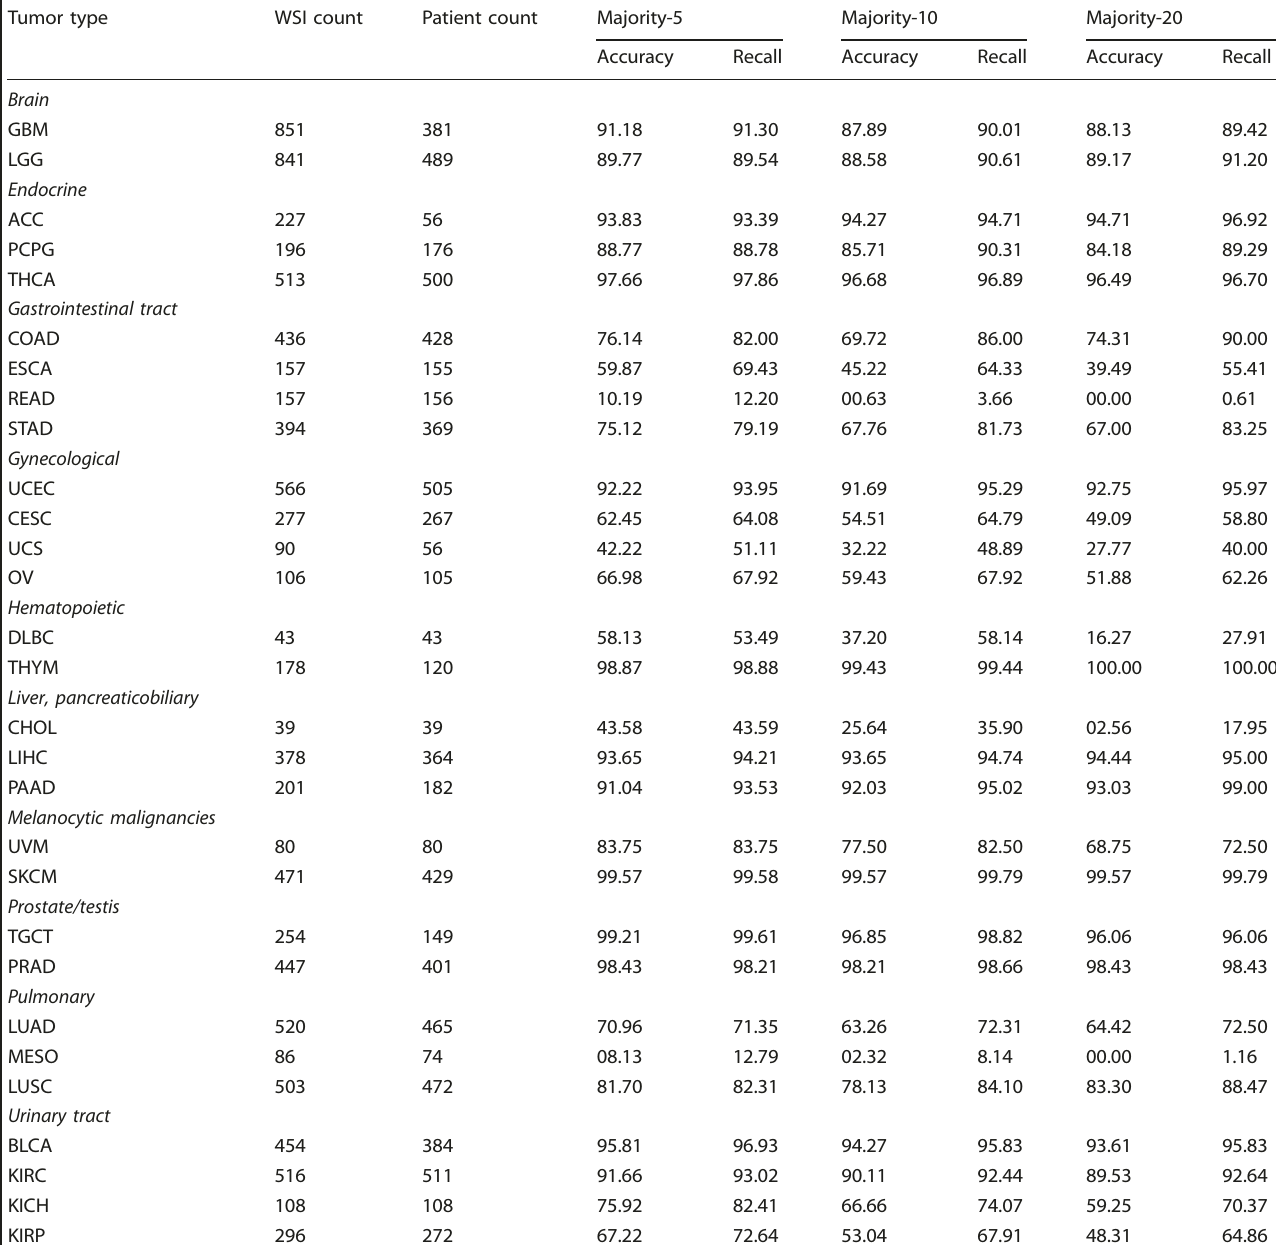
Table 4. Accuracy and recall (sensitivity) for cancer subtype identi fi cation (vertical search) among permanent diagnostic slides. Tumor